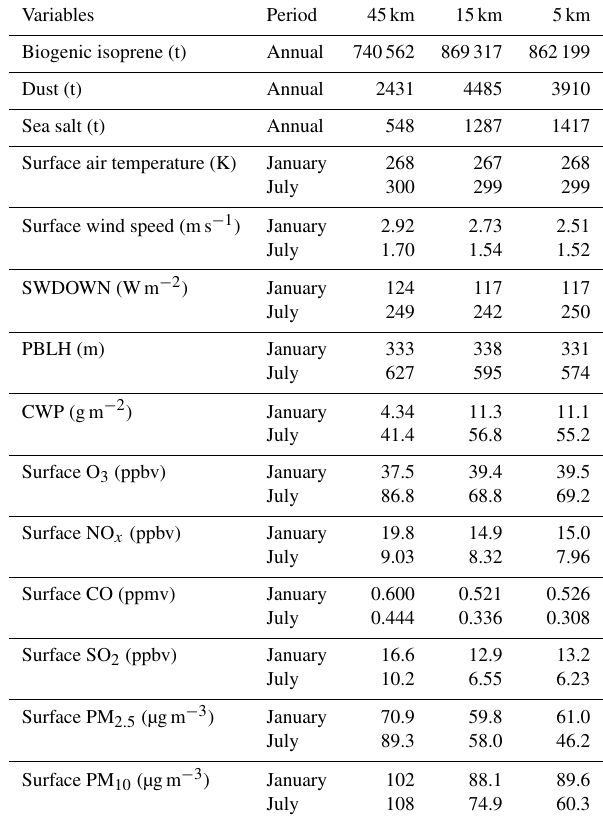
Table 3. Domain total emissions and average meteorology and air quality at various